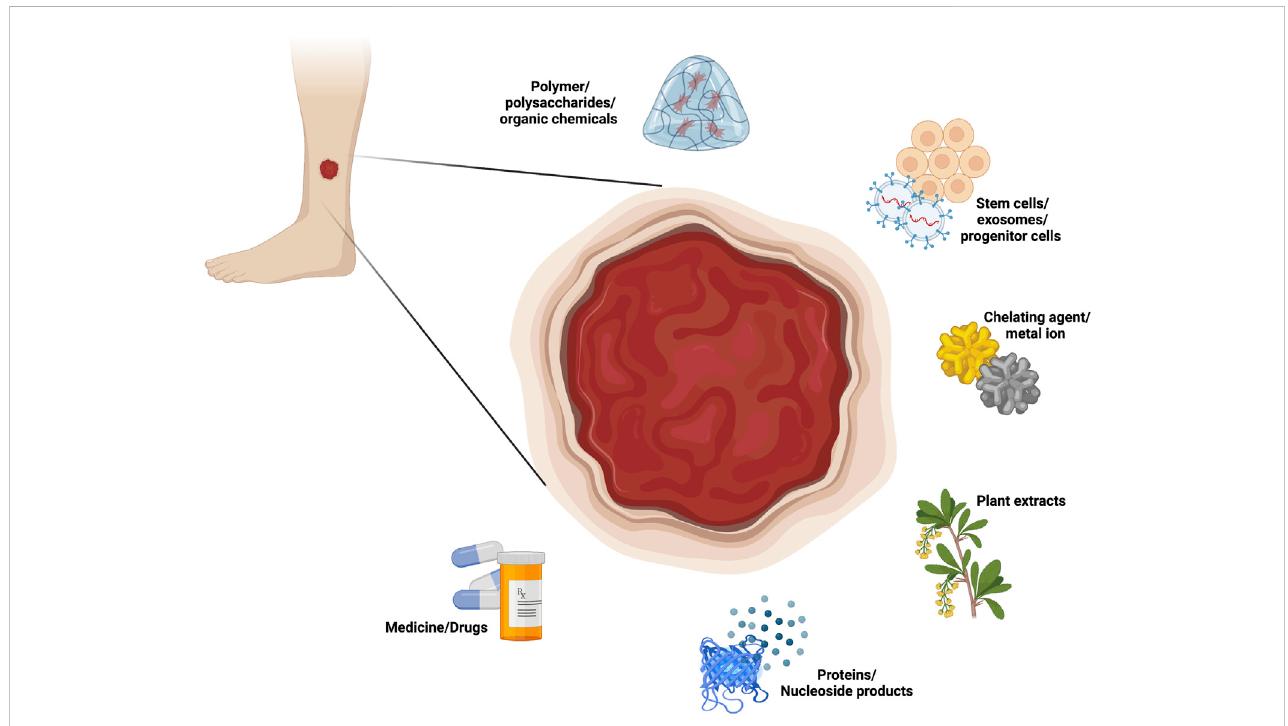
FIGURE 1 Loaded components in composite hydrogel dressings in diabetic wound